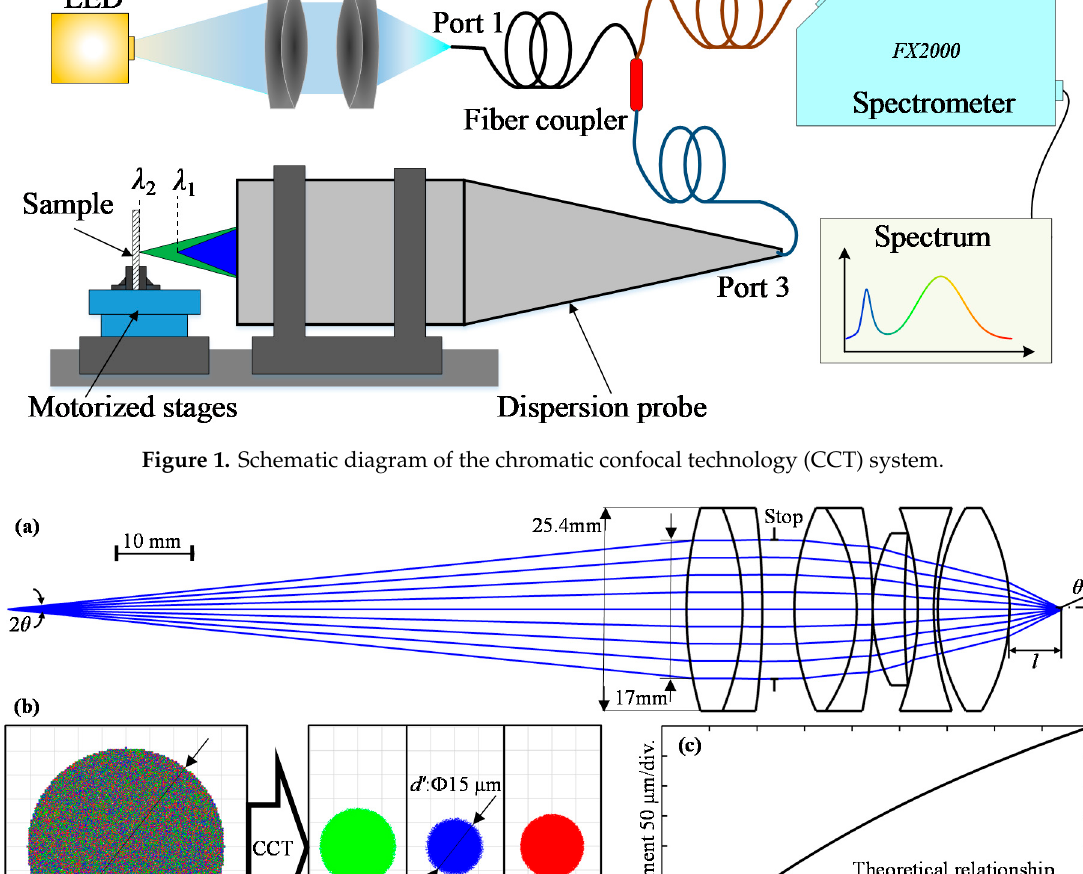
Figure 2. The optical design of dispersion probe: ( a ) Light path at the design wavelength 550 nm; ( b ) The spot diagram diameter change by the CCT probe; ( c ) Theoretical relationship between the wavelength and the displacement.